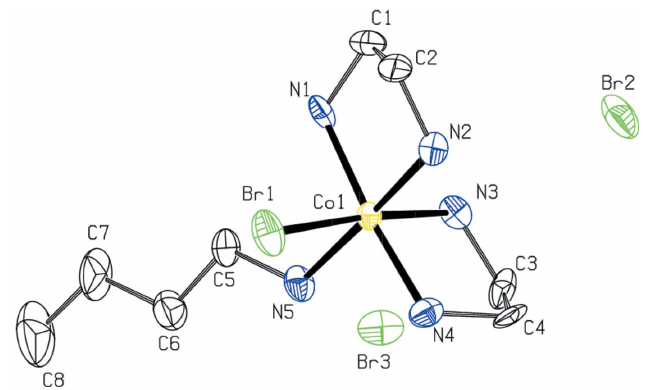
Table 1 Hydrogen-bond geometry (A˚ , (cid:4) ).